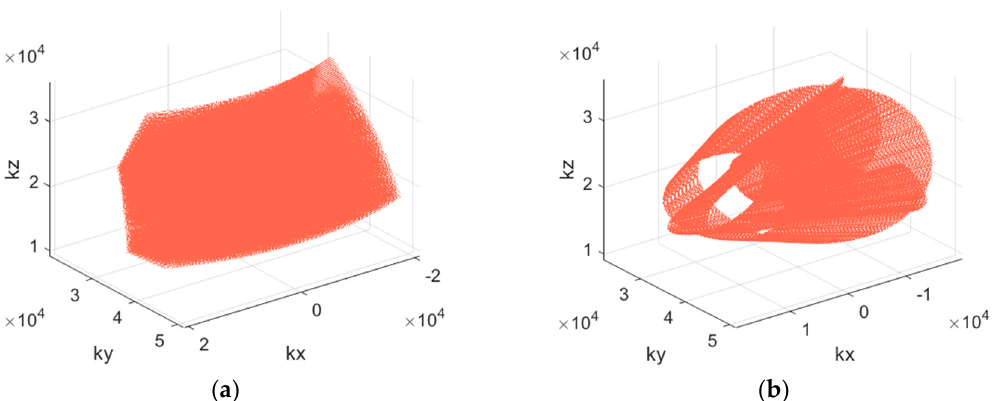
Figure 2. The K-space sampling of Tomo-SAR and five UAVs with SAR system in cooperative flight. ( a ) Tomo-SAR; ( b ) five UAVs with SAR system in cooperative flight.